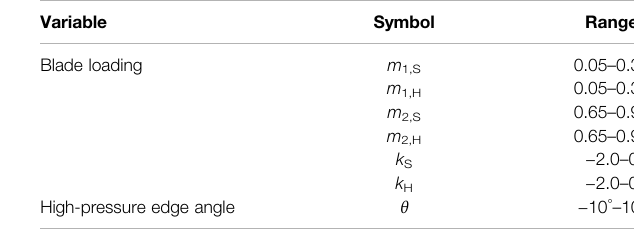
TABLE 3 | Optimization